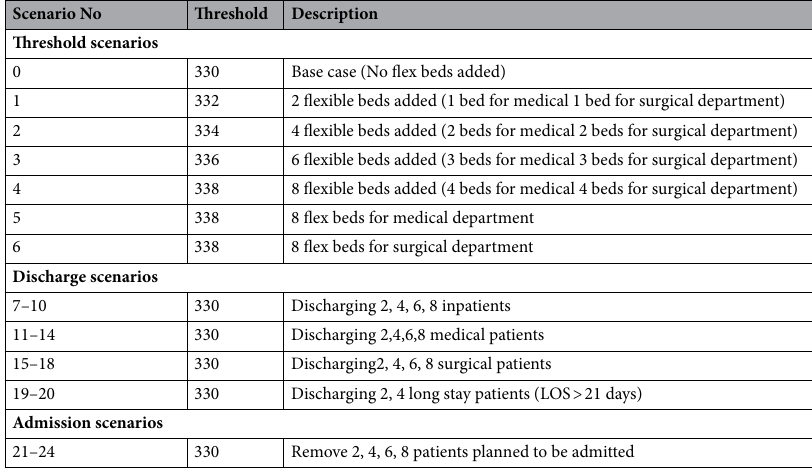
Table 2. Threshold and discharge